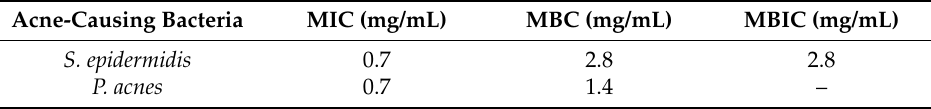
Table 5. MIC, MBC and MBIC of thymol against S. epidermidis and P. acnes